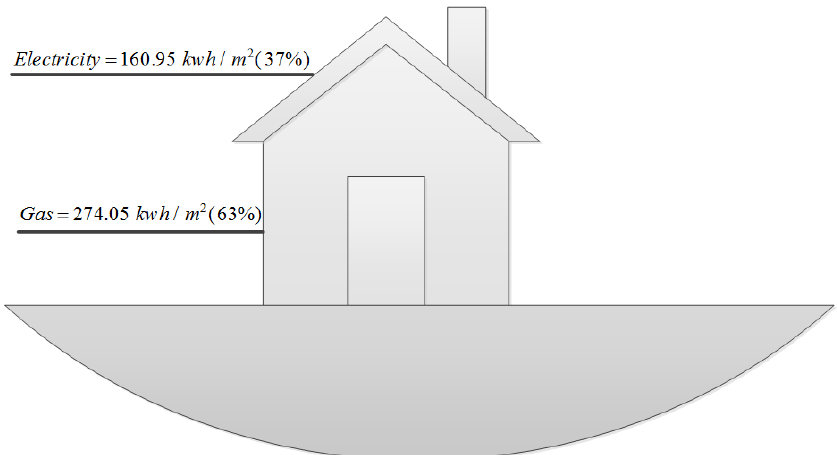
Figure 2 . The energy consumption breakdown before the plan